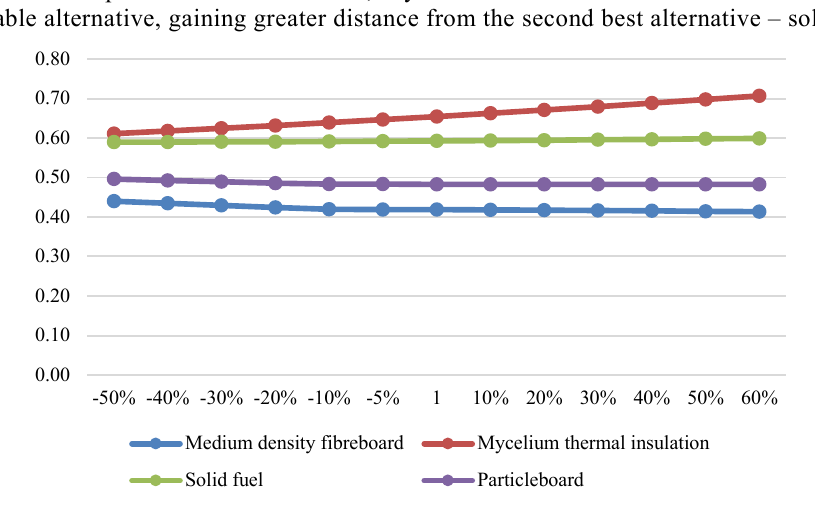
Fig. 5. Sensitivity analysis on mycelium thermal insulation’s market price change on the closeness coefficient to the ideal solution change. As production costs were the only criterion where mycelium thermal insulation material took the lead from the start, sensitivity analysis was conducted to find out how big should be the changes in mycelium thermal insulation production for the material to lose its